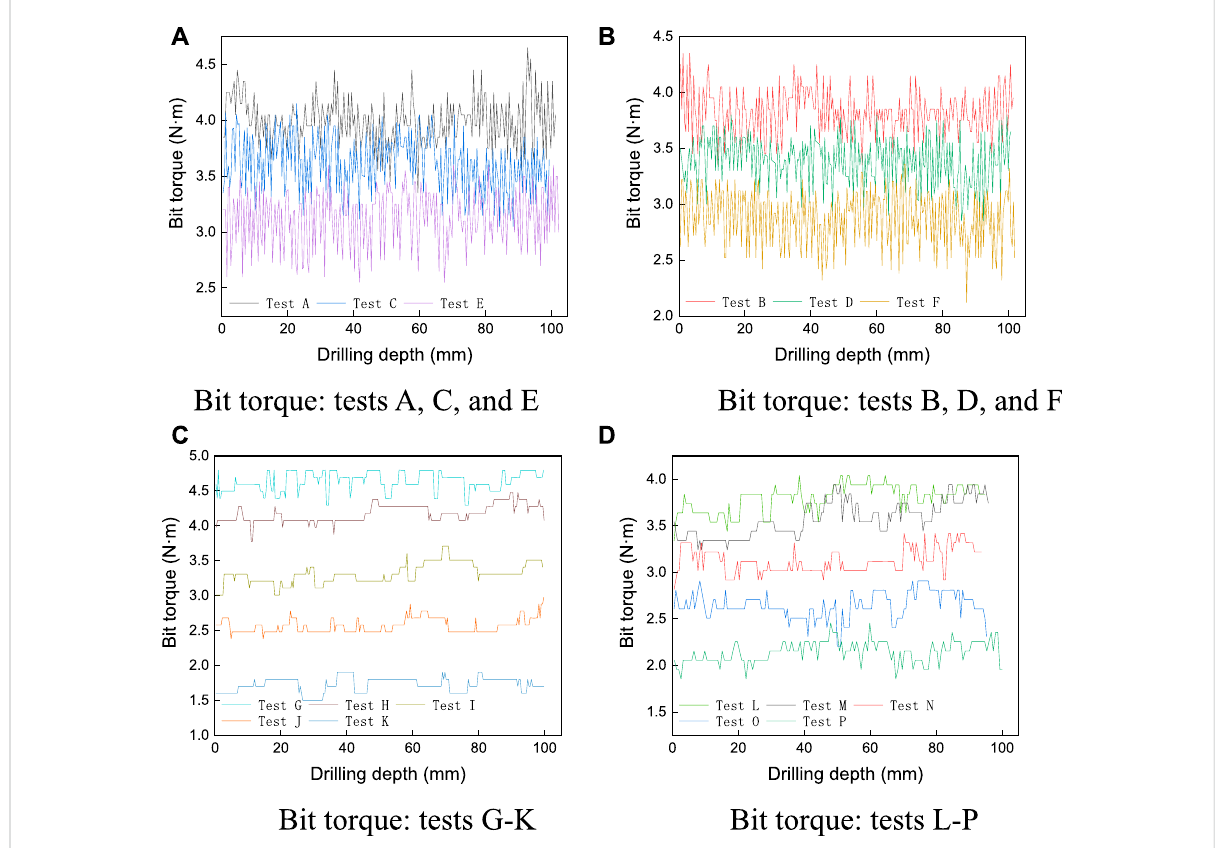
FIGURE 10 Torque v . drilling depth. (A) Bit torque: tests A, C, and E (B) Bit torque: tests B, D, and F (C) Bit torque: tests G – K (D) Bit torque: tests L –